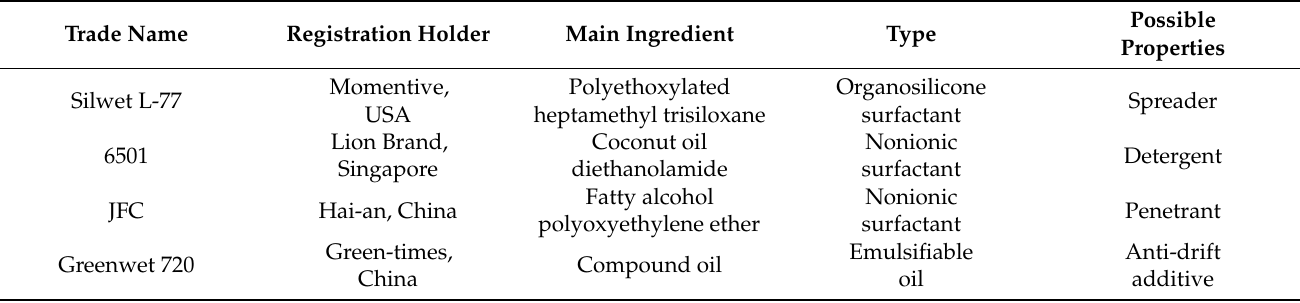
Table 1. Details of selected adjuvants